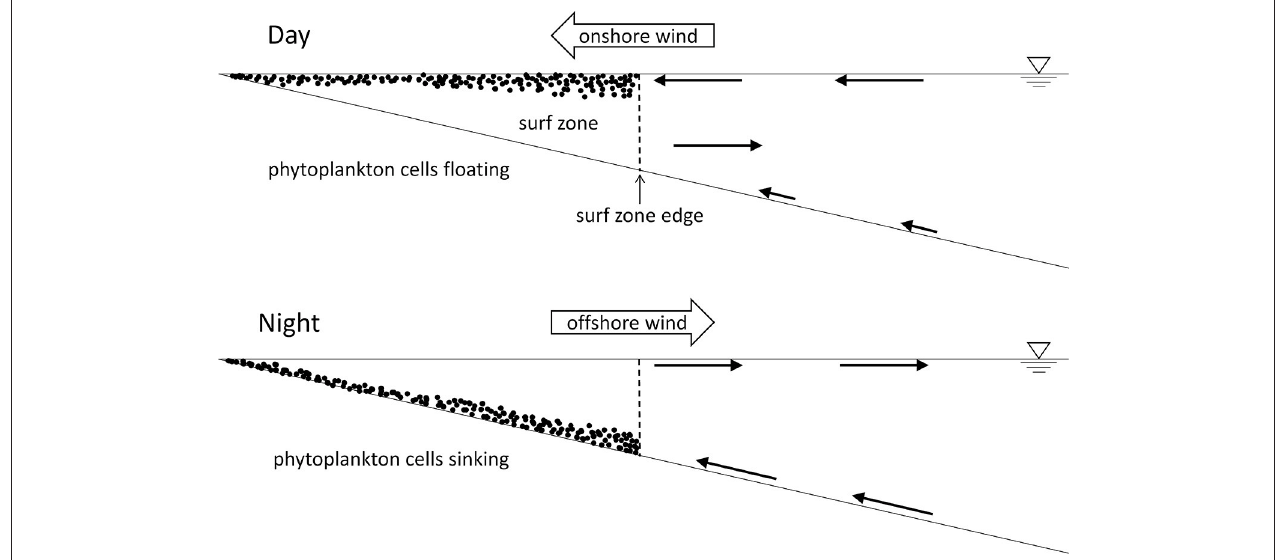
FIGURE 2 | Schematic diagram of water currents (arrows) at a rip-channeled beach. Waves approach shore normal. Curve indicates an isobath.